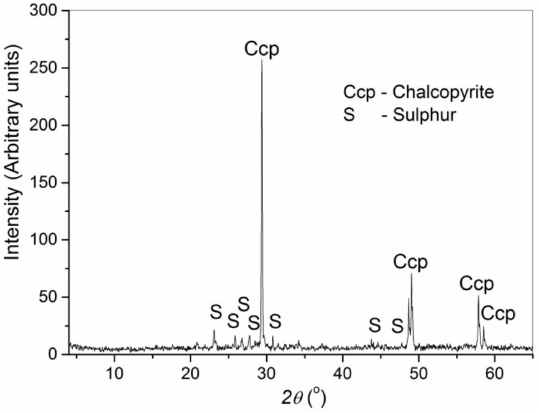
Figure 7. X-ray di ff raction analysis of the leach residue sample.